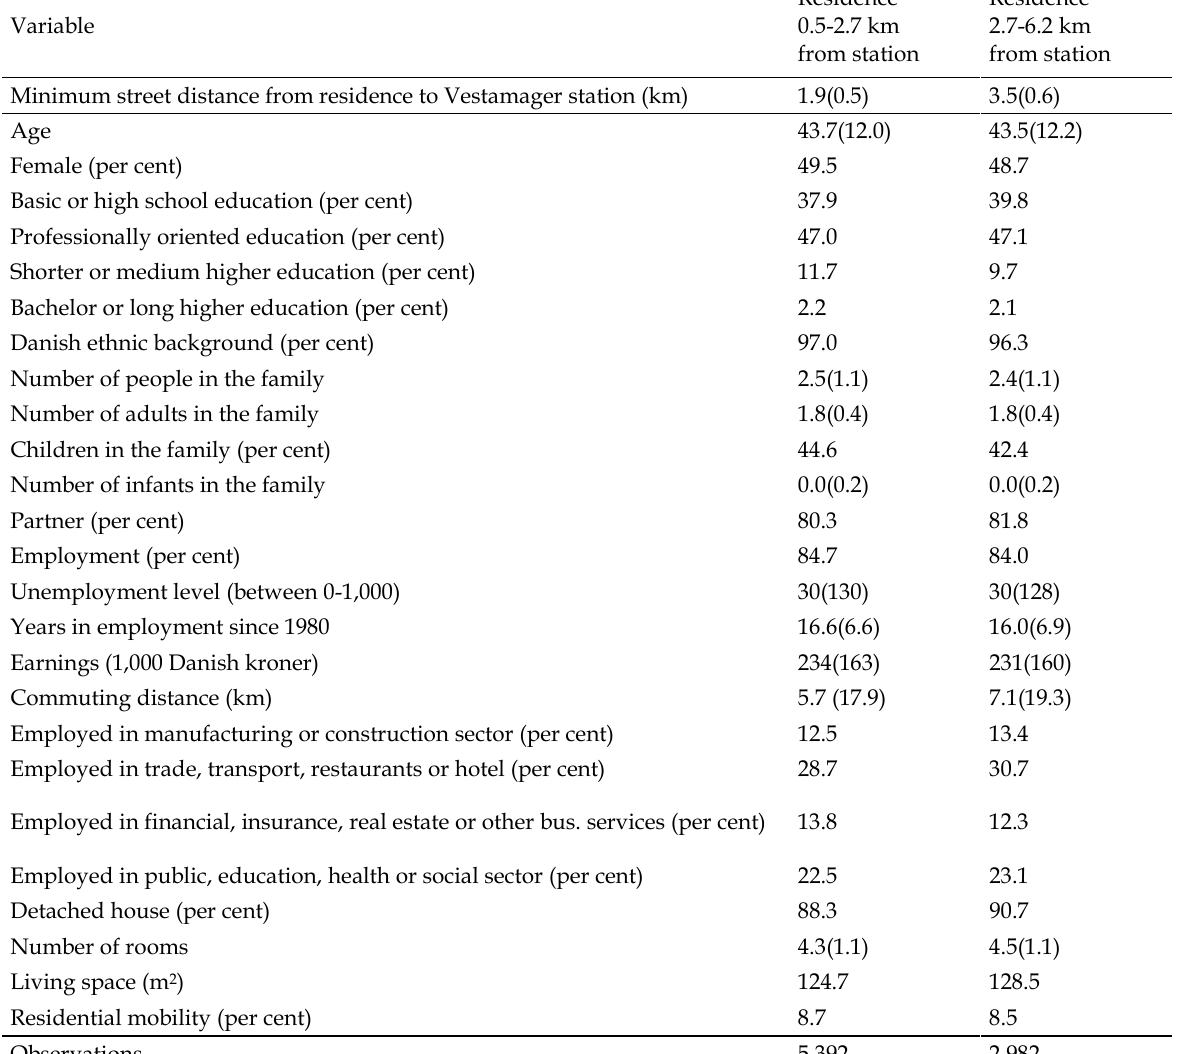
Table 1. Summary statistics for adult working age residents by distance to the under- construction Vestamager station in